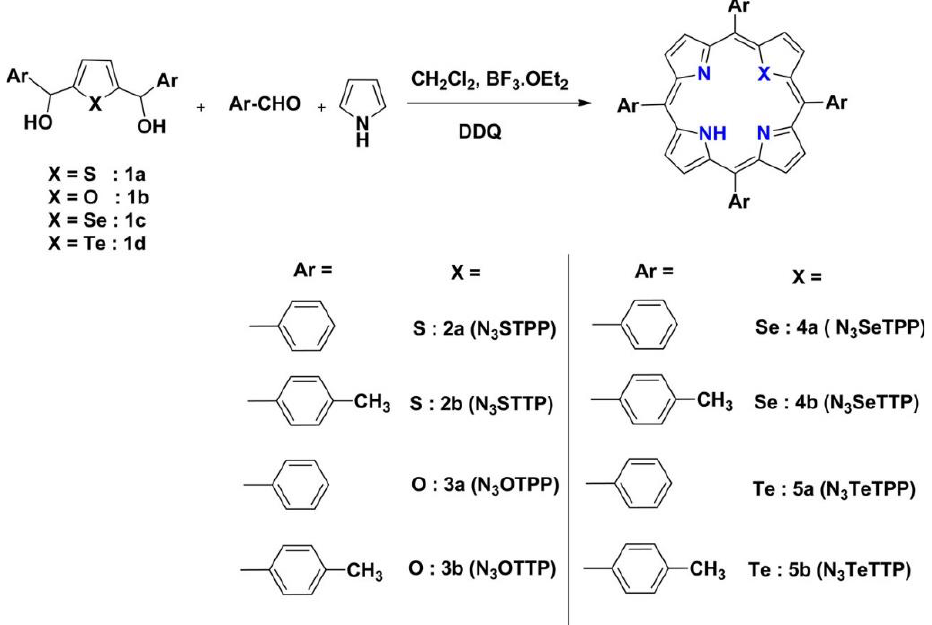
Figure 30. Synthesis of symmetrical 21-monoheteroatom-substituted porphyrins. Reproduced from reference [110] with permission from the American Chemical Society, copyright 2017.